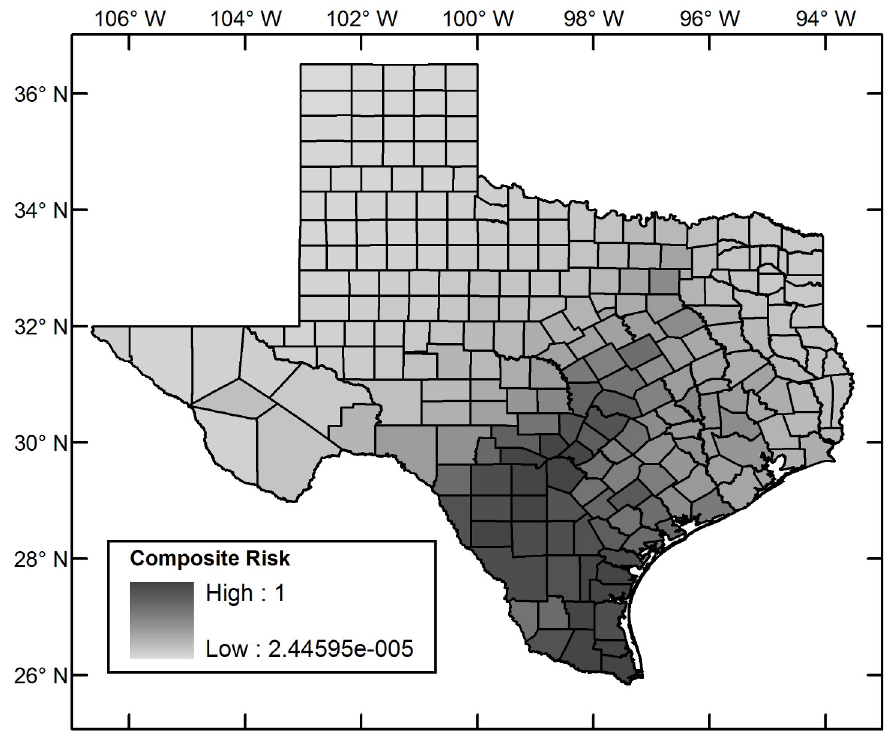
Figure 6. Composite risk map for Chagas Disease in Texas.